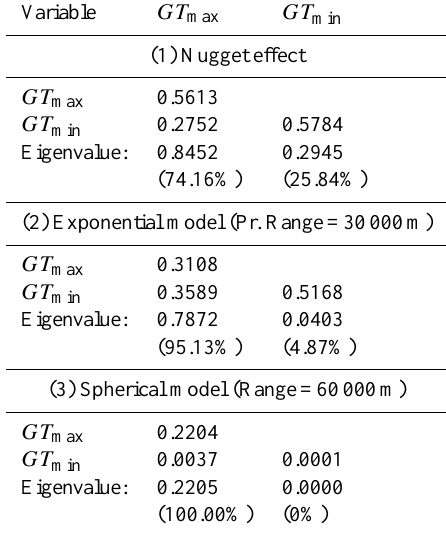
Table 2. Fitted linear model of coregionalization of anamorphosed T max ( GT max ) and T min ( GT min ). The coregionalization matrices, the eigenvalues, and the corresponding percentage of variance ex- plained by each eigenvector for the three basic structures are re-